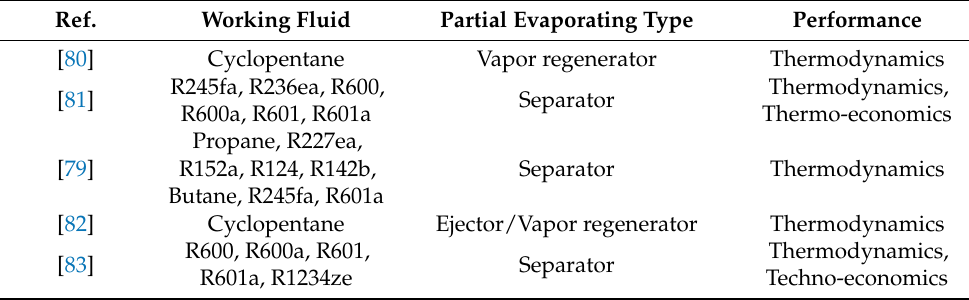
Table 2. Relevant research on the multi-pressure ORC based on partial evaporation.